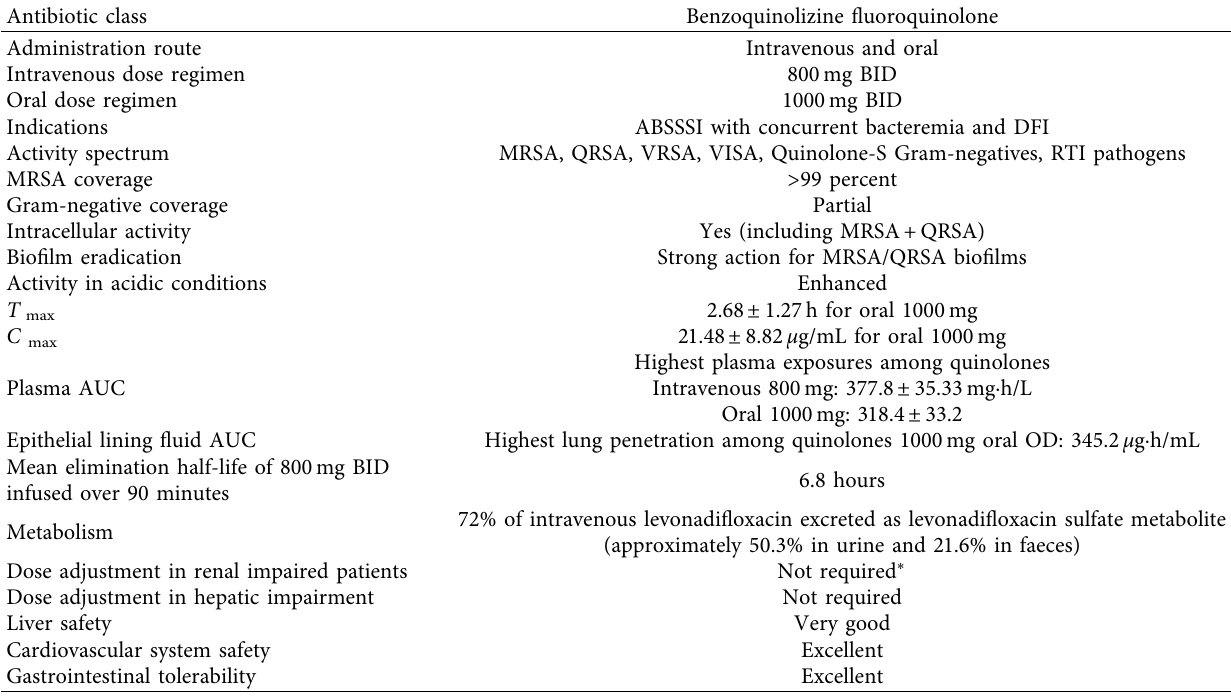
Figure 1: Structure of injectable and oral prodrug of levonadifloxacin. Table 2: Features of